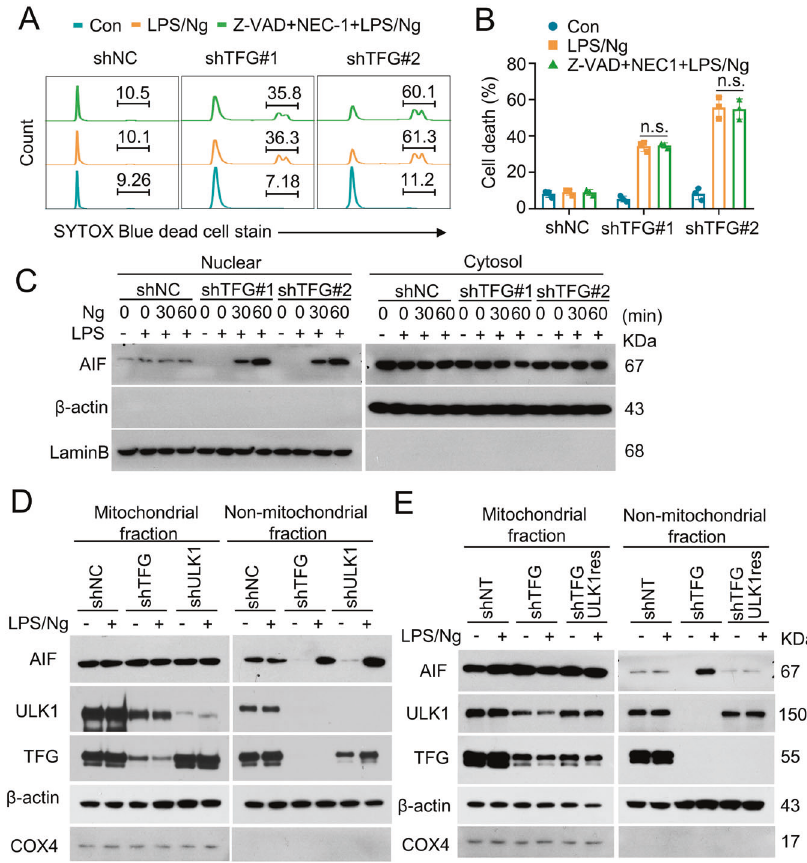
Fig. 8 AIF participates in LPS/Ng-induced cell death. A THP-1 cells (shNC and shTFGs) were stimulated with LPS (1 μ g/mL) for 4 h followed by Nigericin (5 μ g/mL) stimulation for 60 min (LPS/Ng). Z-VAD plus NEC-1 were used to block apoptosis or necrosis. Cell death were